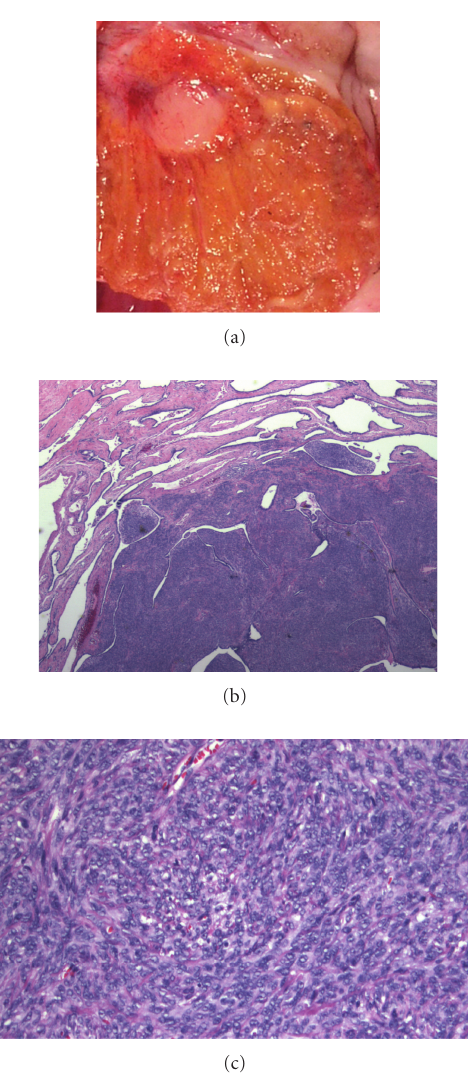
Figure 3: (a) Closer view of gross specimen demonstrating discrete white nodule which was firm. (b) A spindle cell proliferation was intimately associated with unremarkable ductules within the rete testis. (c) Higher power view illustrating bland spindled cell proliferation without mitotic